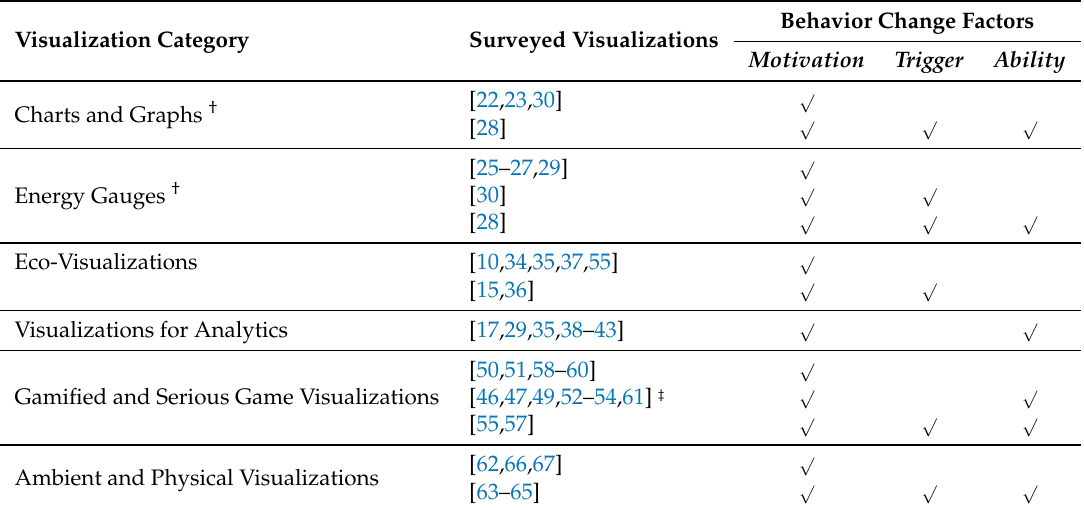
Table 1. The list of the surveyed energy visualization categories and the user behavior change factors they aim to